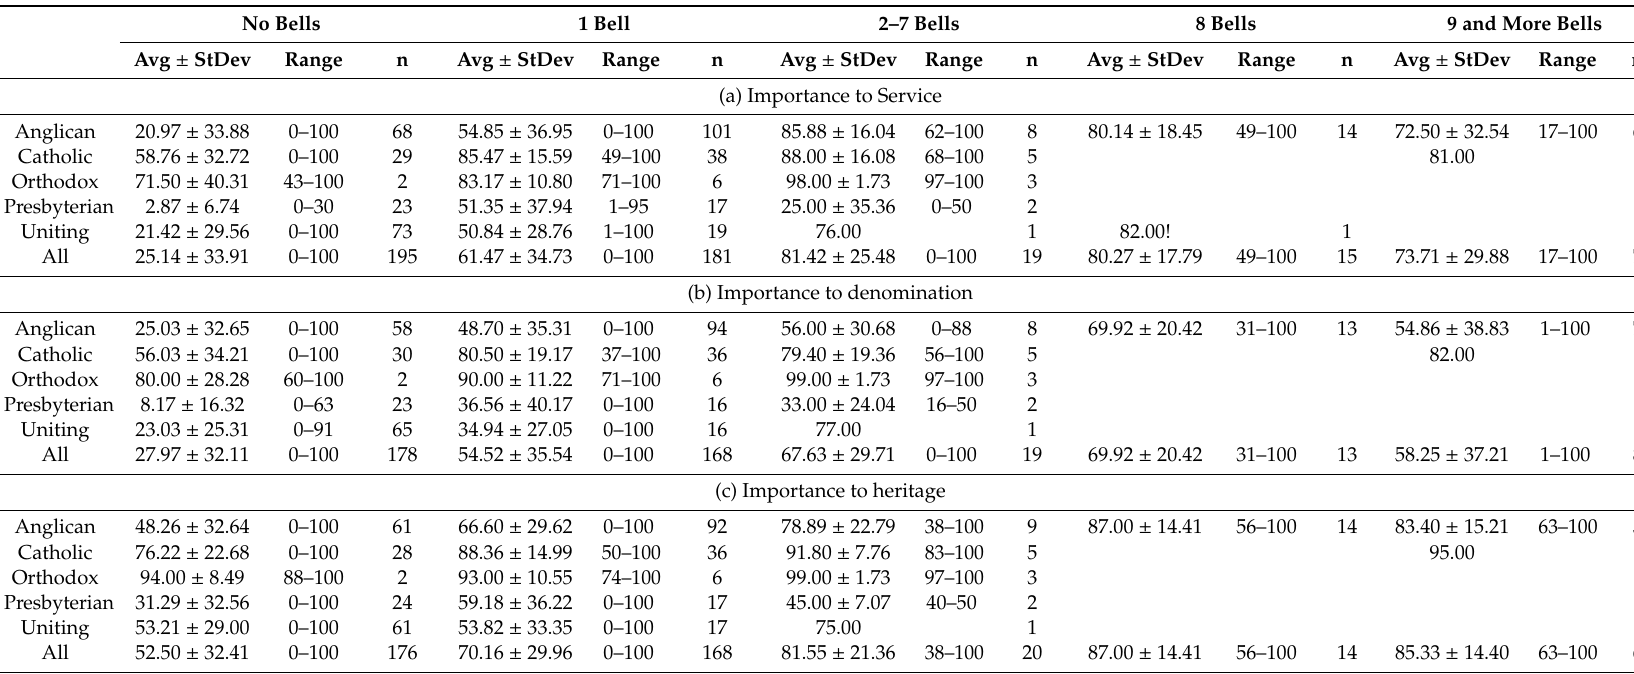
Table 4. NSW Churches’ average ratings of importance of bell ringing ( a ) to the services at your church; ( b ) to your denomination overall; and ( c ) as a form of